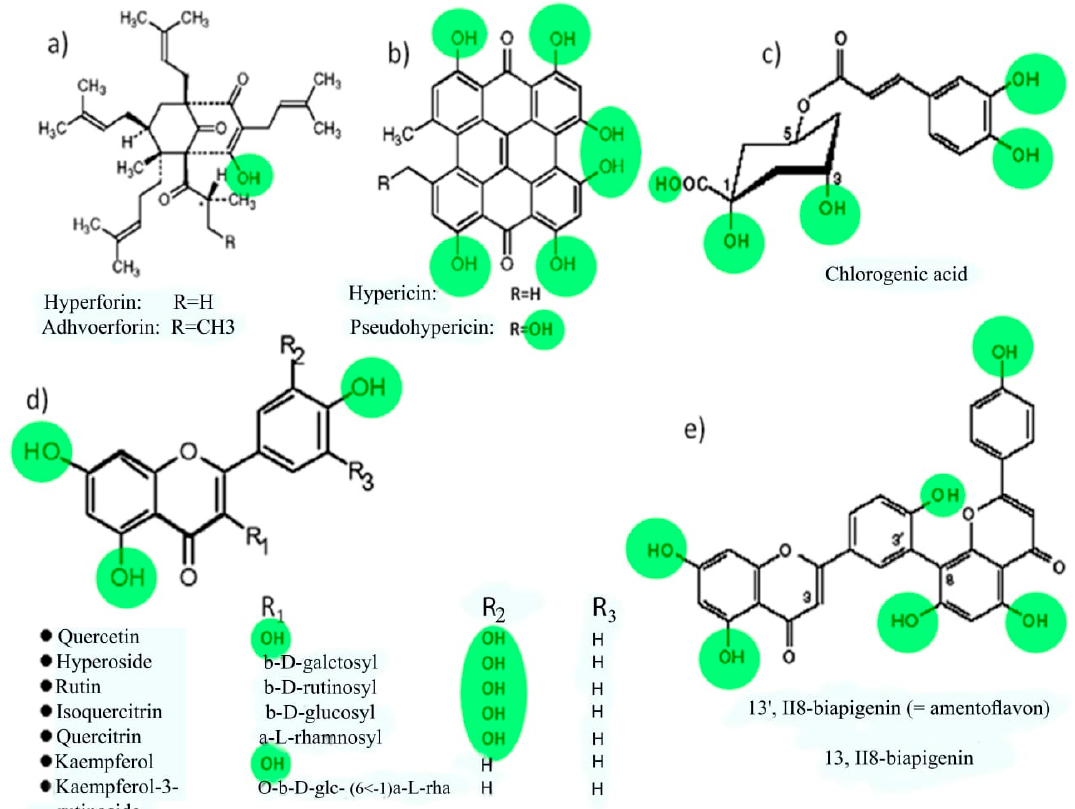
Figure 11. The most important constituents of Hypericum perforatum L. ( a ) represent general formula of Hyperforins, ( b ) Hypericins, ( c ) chlorogenic acid, ( d ) Flavonoids and ( e ) Biflavones